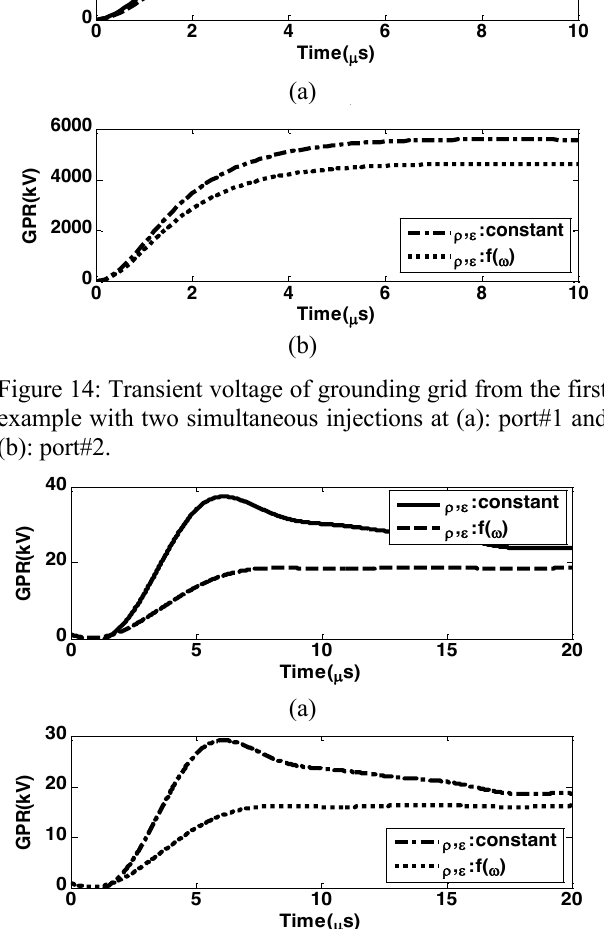
Figure 16: Transient voltage of grounding grid from the third example with two simultaneous injections at (a): port#1 and (b):